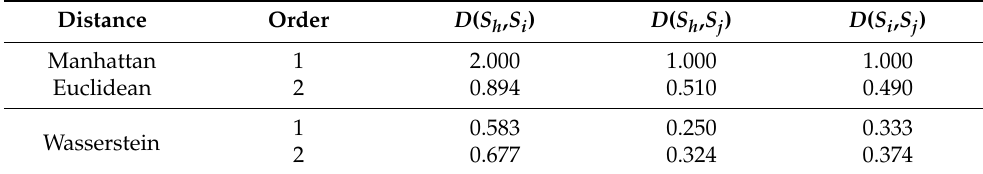
Table 2. The difference between Manhattan, Euclidean and Wasserstein